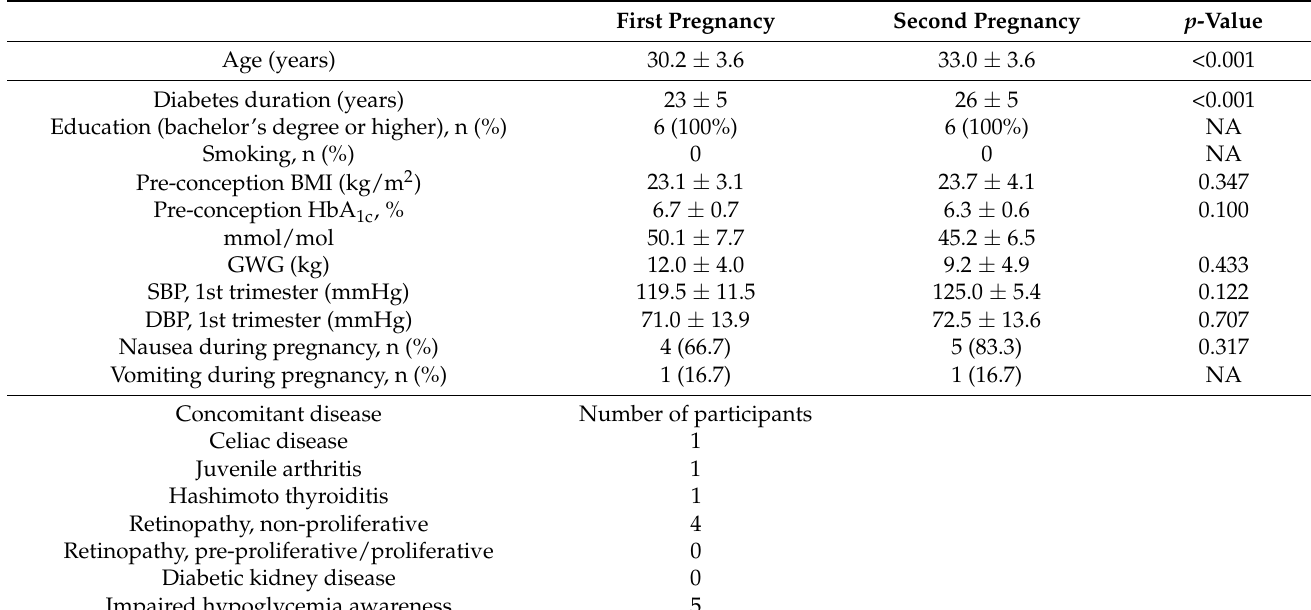
Table 1. Clinical parameters of the pregnant women studied.